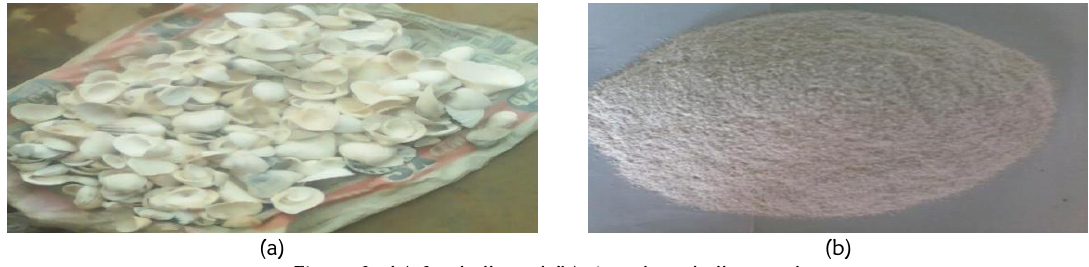
Figure 2: (a) Seashells and (b) sieved seashells powder